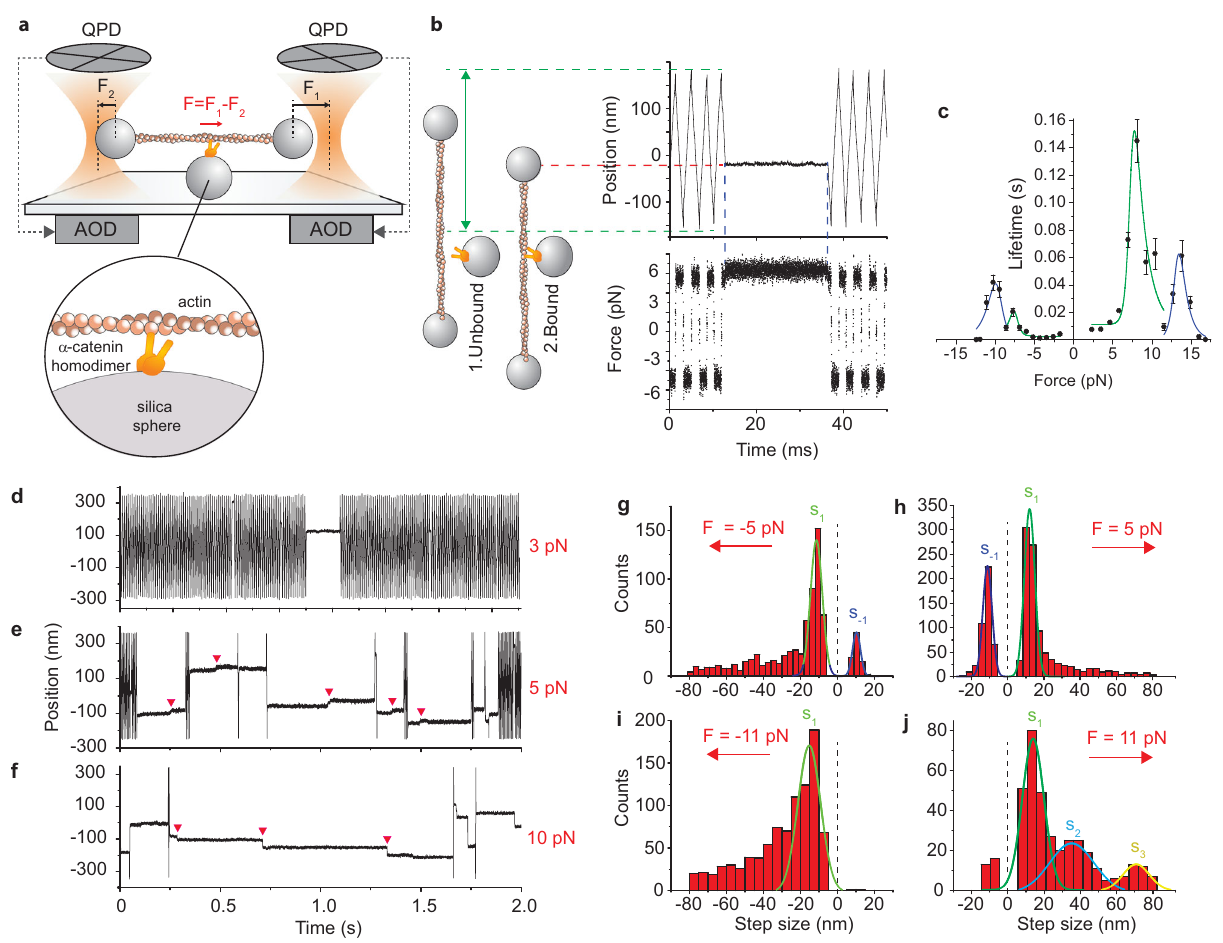
Fig. 1 A single α -catenin homodimer unfolds and resists force on F-actin. a Schematic of ultrafast force-clamp spectroscopy applied to a single α -catenin homodimer. An α -catenin molecule is attached to a glass bead stuck on the coverslip. A single α -catenin homodimer is composed by two His(6x) tagged α - catenins (see methods). An actin fi lament is suspended between two beads trapped in optical tweezers. Black arrows are the force clamped on the right ( F 1 ) and left bead ( F 2 ), red arrow is the net force ( F = F 1 - F 2 ) on the dumbbell. F is alternated in direction to maintain the dumbbell within a limited excursion. b Left: illustration showing the position of the right bead when: (1) α -catenin is unbound and the dumbbell oscillates; (2) α -catenin binds to the actin fi lament. Right: example trace showing displacement and force ( F ~ 6 pN) during the corresponding phases of dumbbell oscillation and α -catenin attachment, under positive and negative loads. c Load-dependent lifetime of the interaction between a single α -catenin homodimer and F-actin. Green and blue lines are, respectively, fi t of the low-force and high-force peak with the two-state catch-bond model (see methods). n = 23234 total number of interactions for all points in the plot. Error bars, s.e.m. d – f Example traces under force of about 3 pN, 5 pN, and 10 pN, respectively. Red arrowheads indicate steps occurring during the interaction. g-j , Distribution of step size at various forces. Gaussian fi ts of the main peaks (green, blue, and yellow lines) are also shown with their center and s.d. g F = − 5 pN, s 1 = − 11.3 ± 6.4 nm, s − 1 = 10.3 ± 4.3 nm h F = + 5 pN, s 1 = 12.1 ± 5.8 nm, s − 1 = − 11.2 ± 5.1 nm i F = − 11 pN,